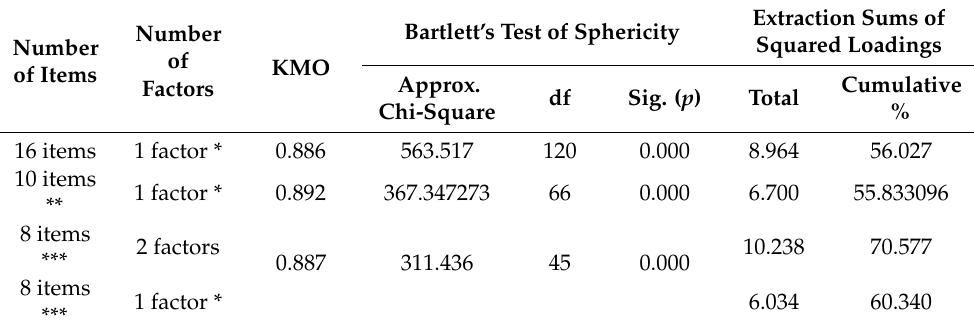
Table 2. Subscales and factor analyses results of the pilot